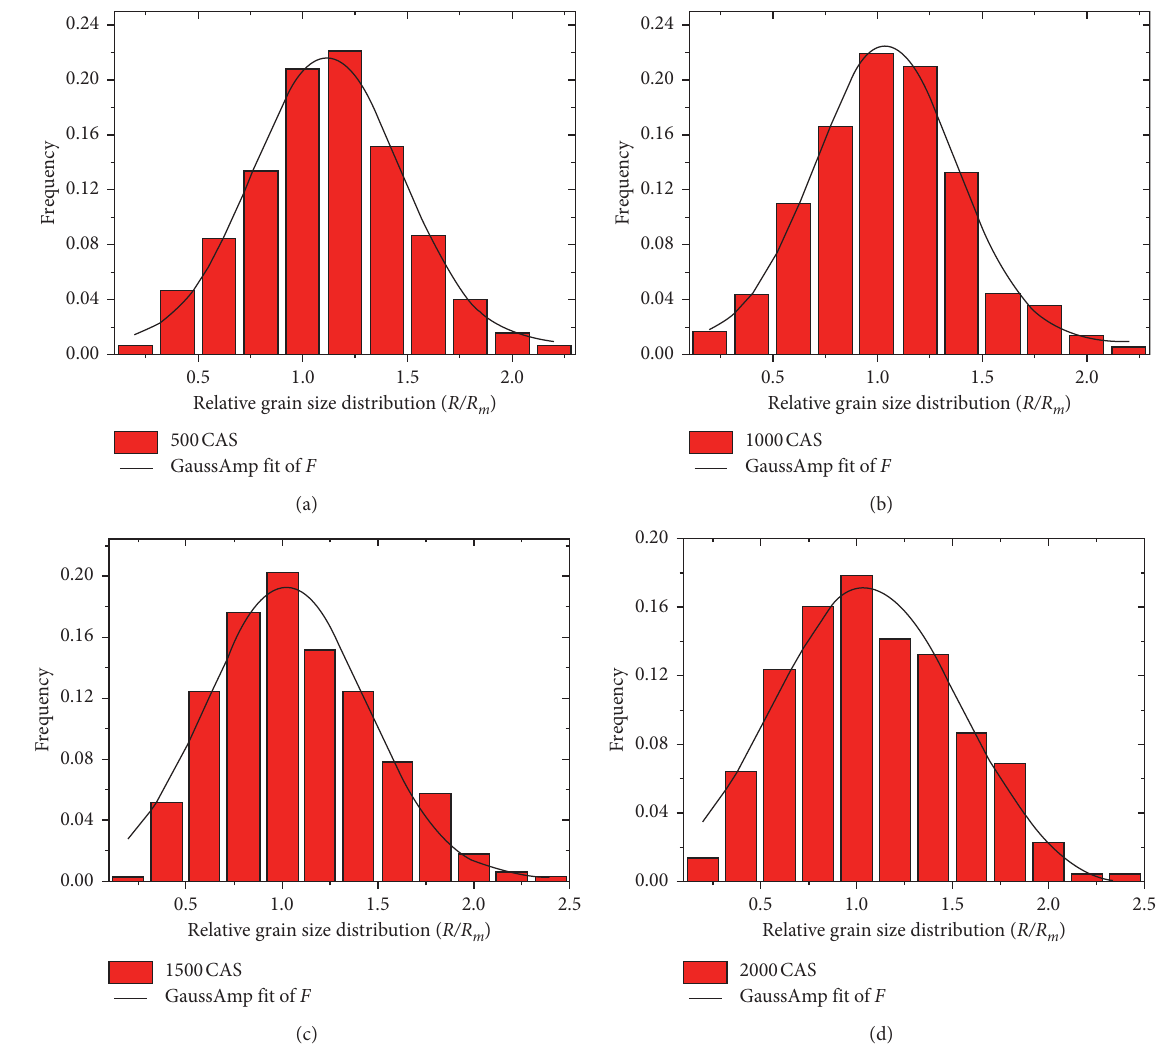
Figure 8: Grain size distribution at different times at 420 ° C: (a) 500CAS, (b) 1000CAS, (c) 1500CAS, and (d) 2000CAS.